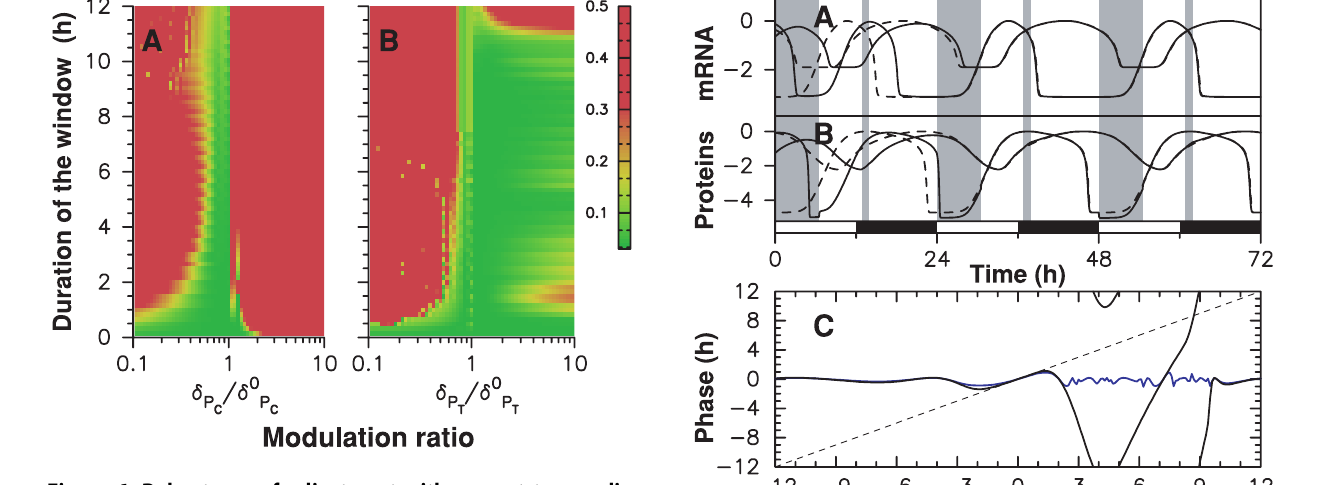
Figure 6. Robustness of adjustment with respect to coupling strength and window duration. Color-coded adjustment RMS error as a function of window duration and modulation ratio (ratio of degradation rates inside and outside the coupling window). (A) Modulation of CCA1 protein degradation rate; (B) Modulation of TOC1 protein degradation rate.